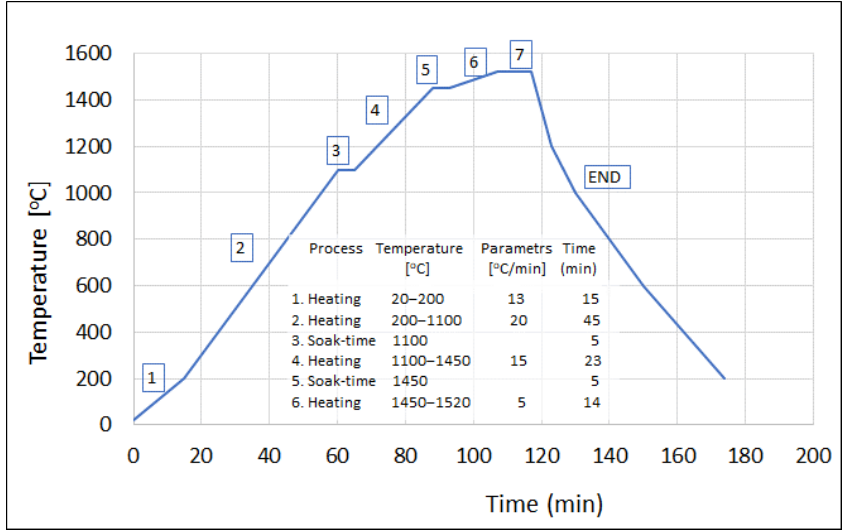
Figure 2. Scheme of single heat treatment: (stage 7) 20 min liquid phase sintering at temperature 1520 °C.